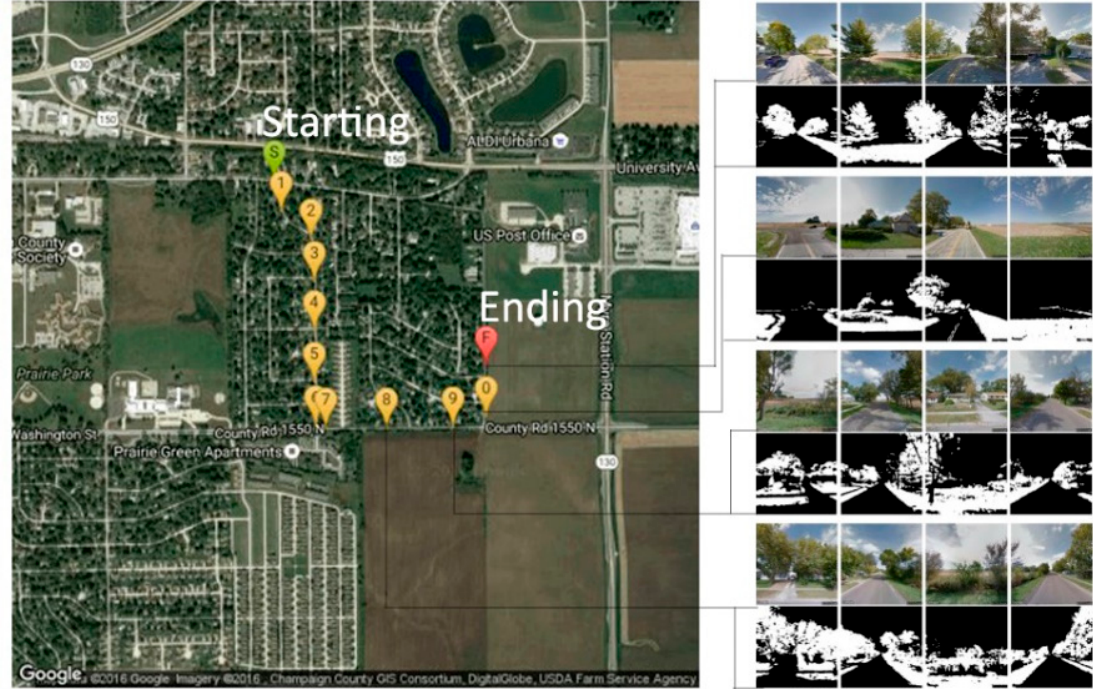
Figure 1. Green Index on A Route: S is the starting point and F is the ending point of the route. We extracted 4 street view images every 20 m along the route. For each image, the percentage of green pixels is calculated which is the vegetation density.